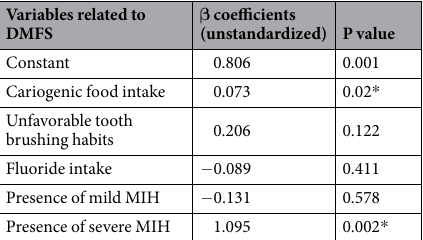
Variables related to DMFS